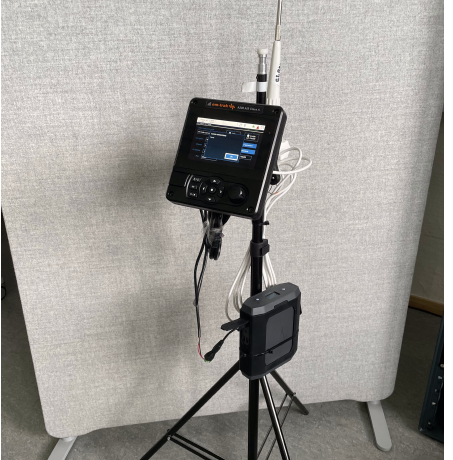
Figure 5. The A200 connected to a battery and a VHF antenna.